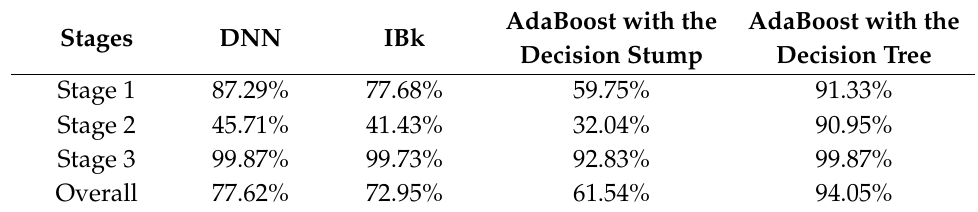
Table 23. Average of the accuracy of each implemented